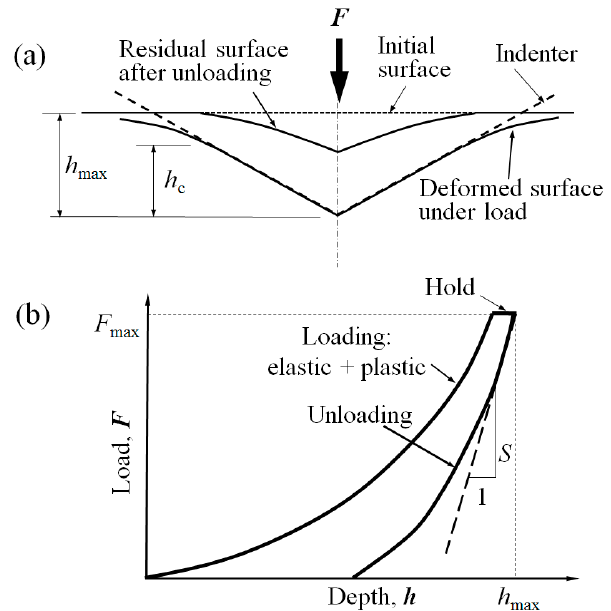
Figure 2. Schematic illustration of ( a ) nanoindentation loading and unloading processes and ( b ) the corresponding load–displacement curve.